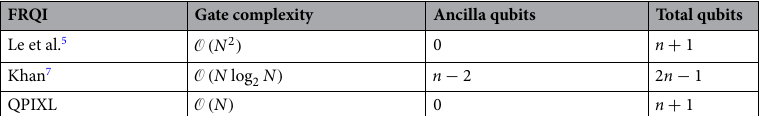
I FRQI for an image with | �